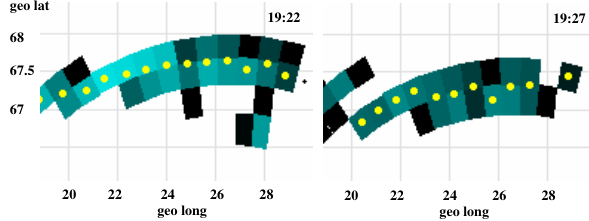
Fig. 6. Geographical location of the regions of HF power scattering.